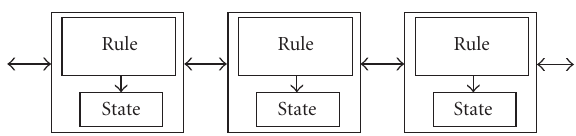
Figure 2: A one-dimensional nearest neighbor cellular